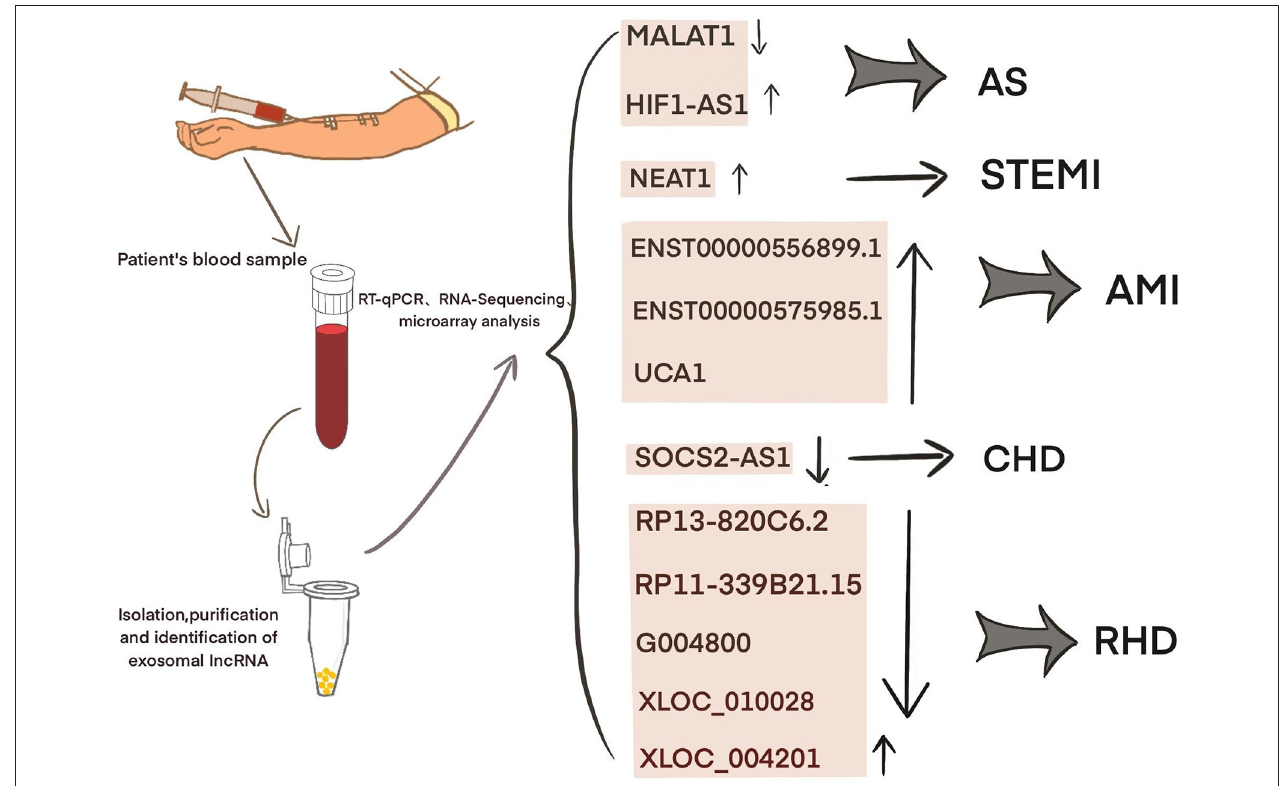
FIGURE 3 | Exosomal lncRNA in the serum of CVD patients as potential